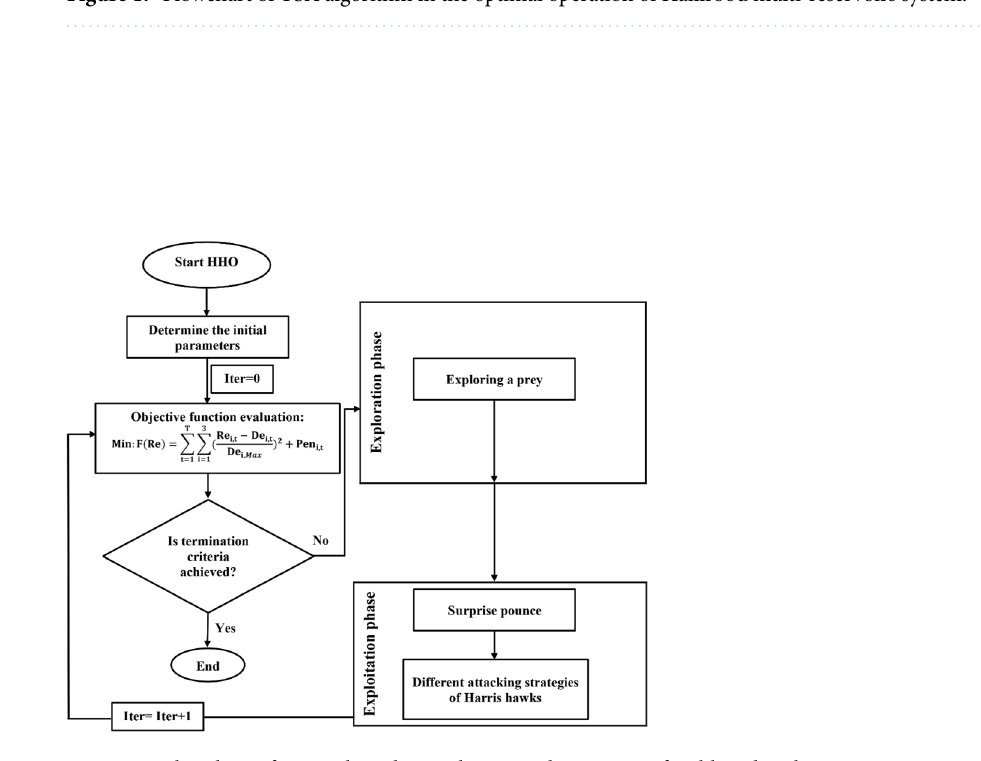
Figure 2. Flowchart of HHO algorithm in the optimal operation of Halilrood multi-reservoirs